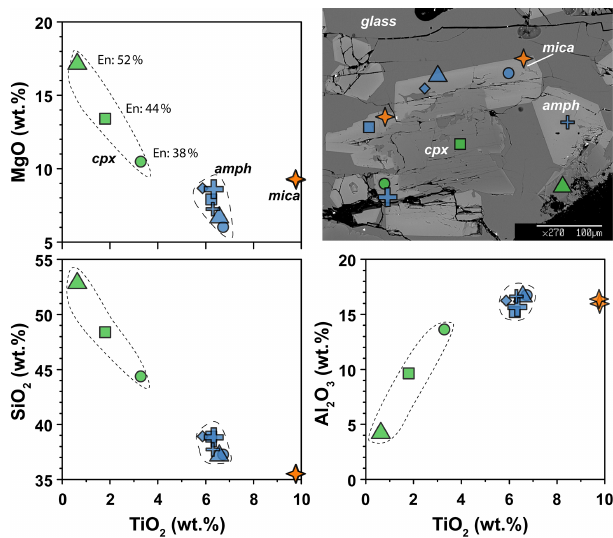
Figure 6. Major element compositions of amphibole, clinopyrox- ene, and mica in experiment 17-4C. BSE image shows the represen- tative texture and the location of the chemical analyses. En: enstatite component in clinopyroxene (expressed in